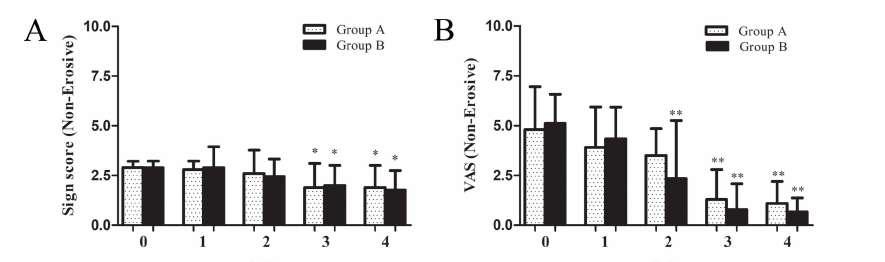
Figure 3. Sign score ( A ) and VAS ( B ) trends before and after treatment of patients with non-erosive OLP in Group A using dexamethasone plus gentamycin mouthwash and Group B by dexamethasone plus gentamycin mouthwash combined with TGP capsules. * Compared with initial visit, * p < 0.05, ** p < 0.01.